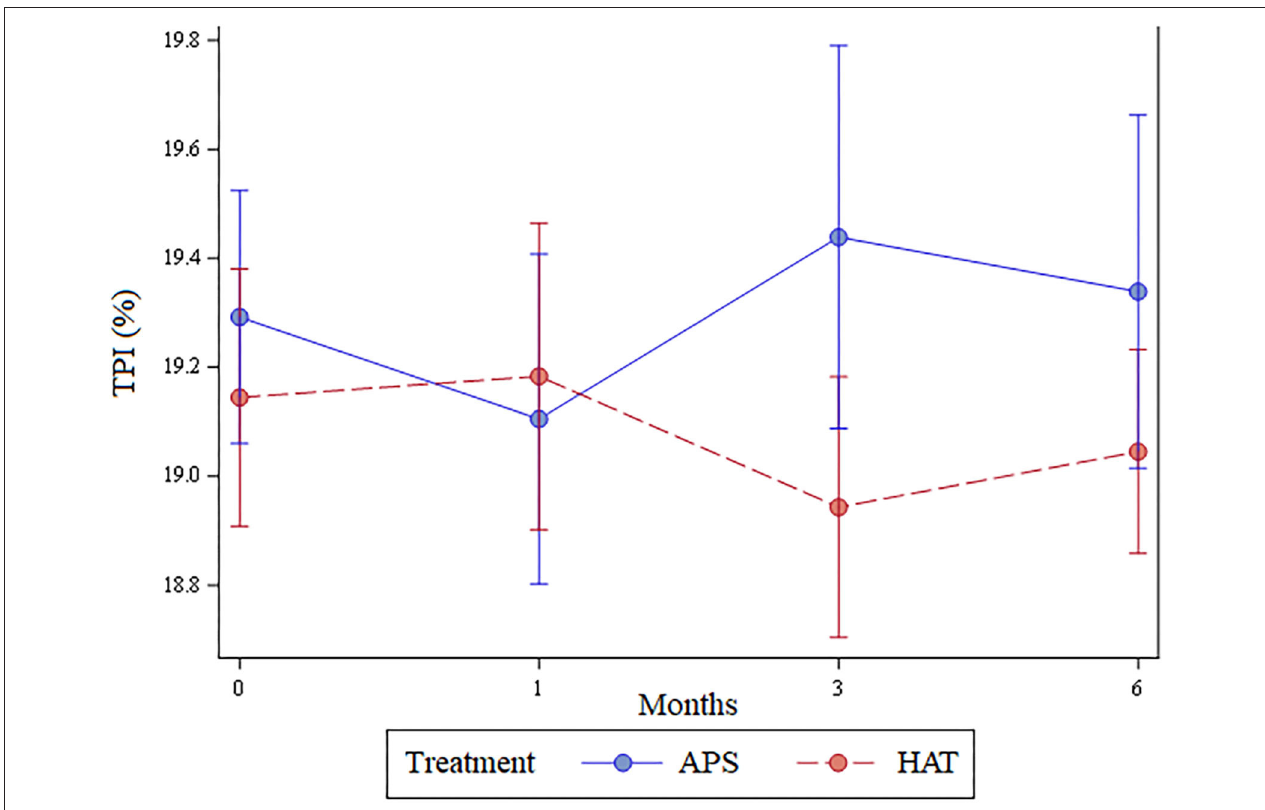
FIGURE 3 | Total pressure index (mean ± SE) over the 6-month study for APS and HAT treated